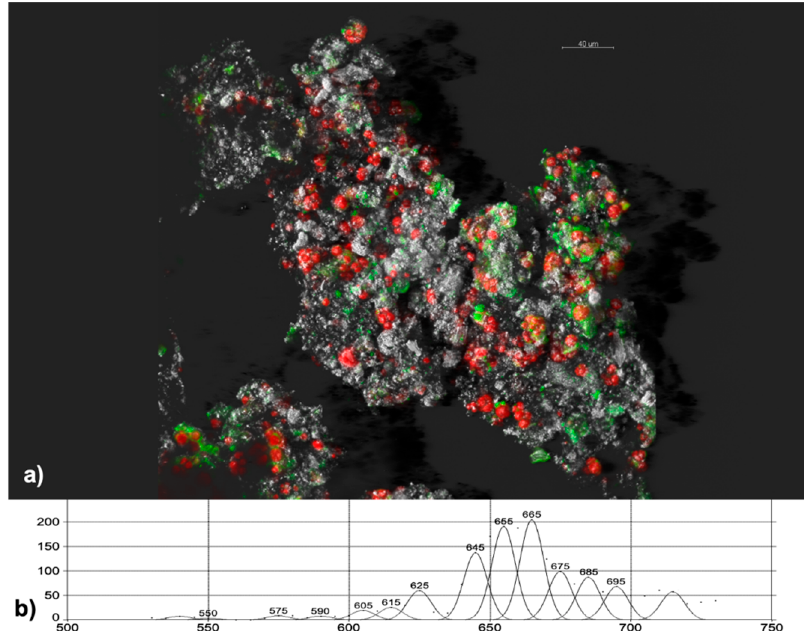
Figure 4. ( a ) Confocal laser scanning imaging of biofilm growing on untreated Candoglia marble. Colour key: phototrophs, red (autofluorescence); chemotrophs, green (Syto9); stone, grey (reflection). Scale bars are 40 µm. ( b ) Emission spectrum recorded from coccoid cyanobacterial cells. Spectral profile shows individual phycobiliproteins: phycoerythrin, 575 nm; phycocyanin, 645 nm; allophycocyanin, 665 nm; chlorophyll a, 685 nm.